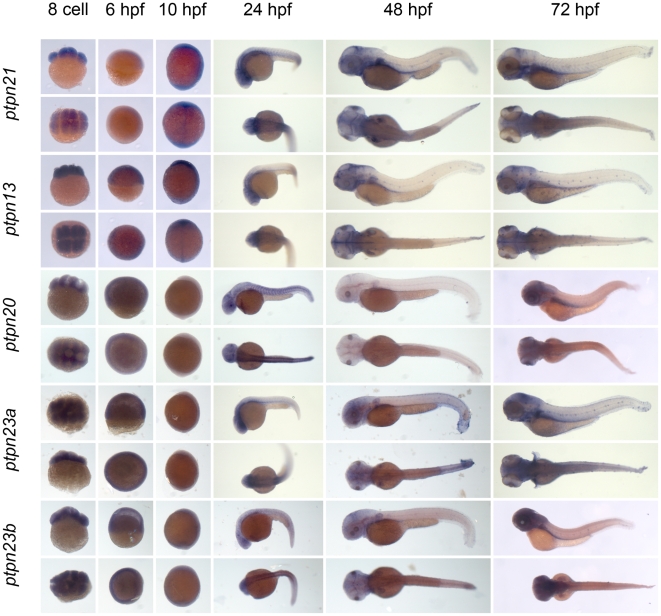
See legend to Fig. 3.